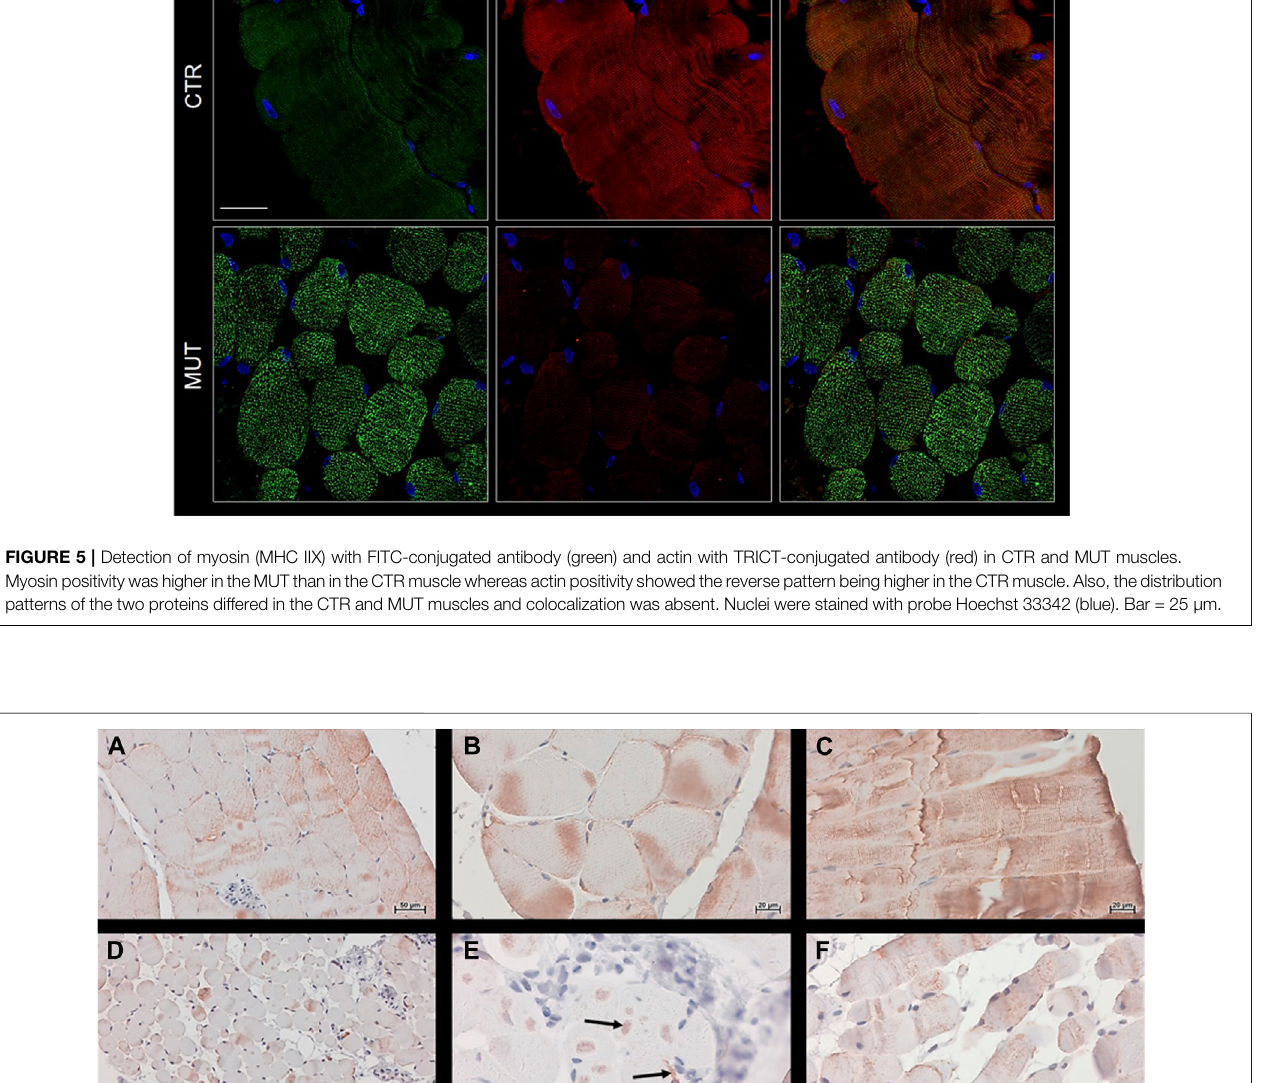
RG values than the wild-type counterparts. For instance, the nucleotide-free mutant ( Figure 11 , right panel, black) had a trend opposite to that of the wild-type nucleotide-free protein, with increasing values, 2.9-3.2 RG for the mutant and decreasing values, 2.9-2.7 RG, for the wild-type molecule ( Figure 11 , left panel, black).